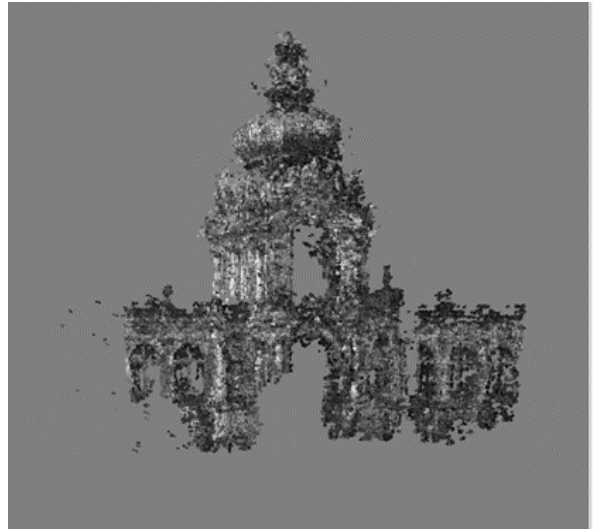
Figure 6. Historical point cloud (interior view of the